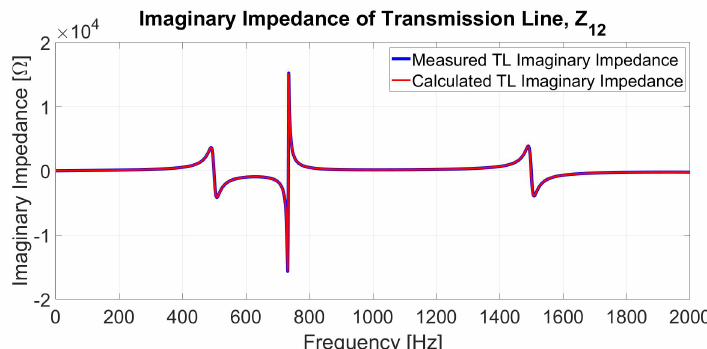
Figure 14. Frequency response measurements and the proposed model calculation of transmission line imaginary impedance ( Z 12